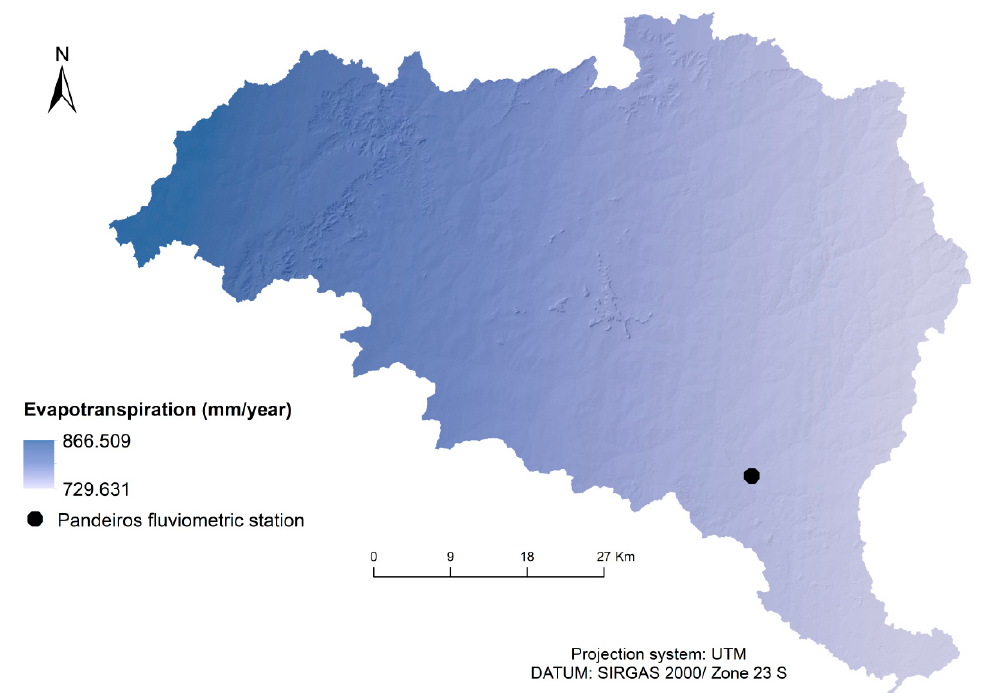
Figure 8. Spatial distribution of evapotranspiration in the Pandeiros River basin.